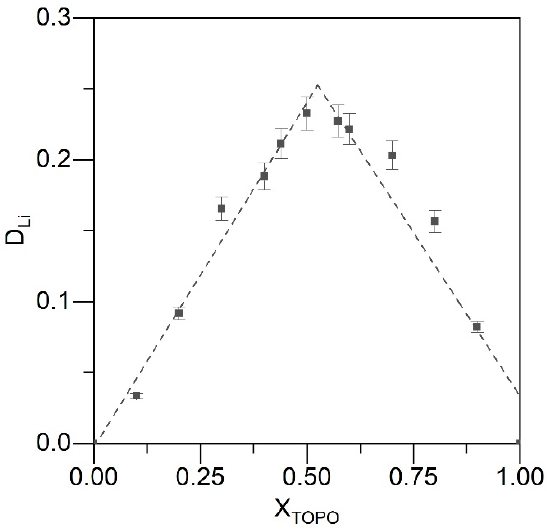
Figure 5. Influence of mole fraction of TOPO on lithium extraction. O/A = 1:1, C Li = 0.02 mol L − 1 , C NaOH = 0.1 M.